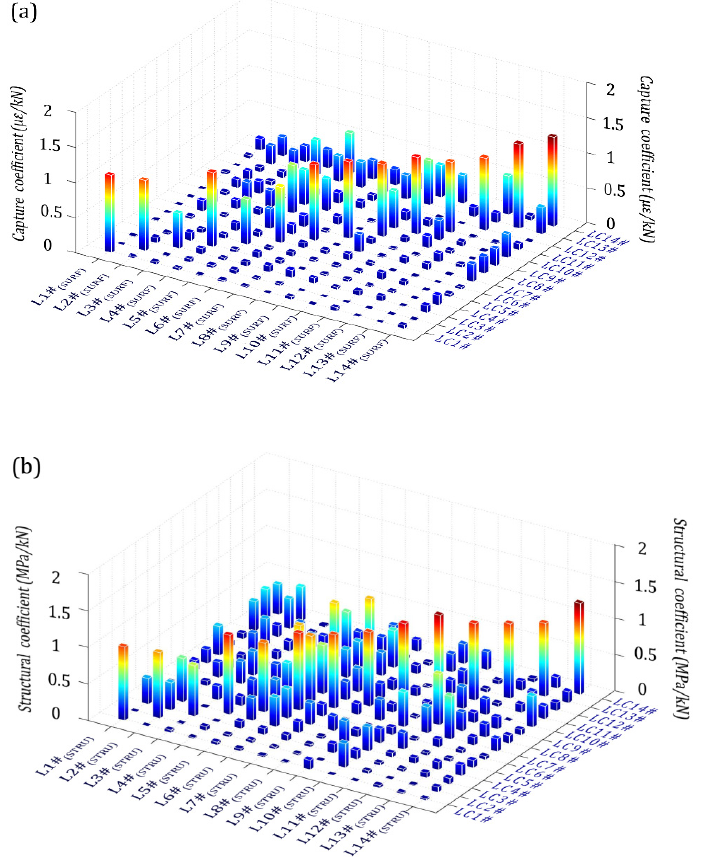
Figure 5. Contour bar plot of captured strain and reconstructed stress to identified loads. ( a ) Surface strain ‐ identified load; ( b ) Reconstructed stress ‐ identified load.